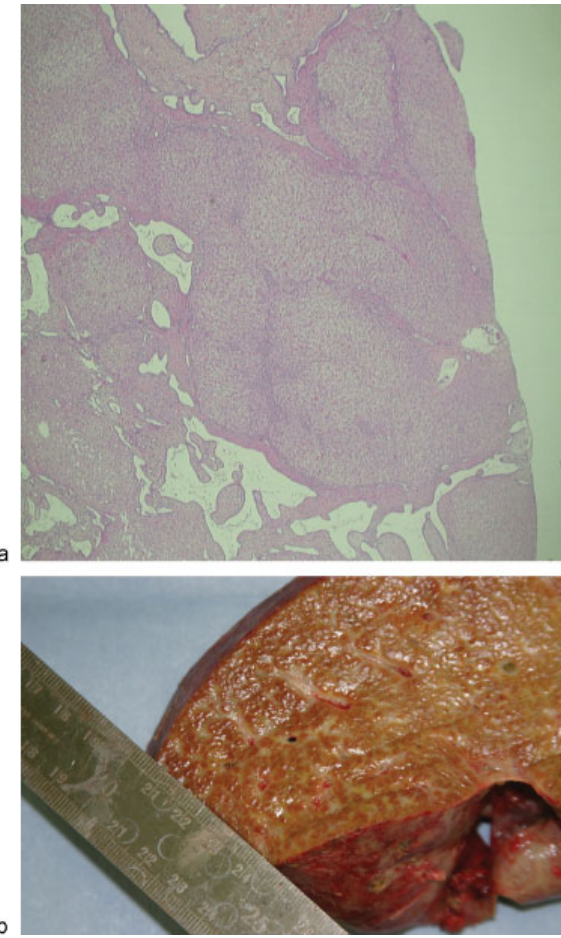
Fig. 2 ( a ) On histological examination of the liver biopsy specimen, portal areasgreatlyexpanded by fi broustissueand increased bile ducts are seen. The bands sometimes connect with adjacent portal tracts. Distorted irregular bile ducts are noted in the portal tracts (hematoxylin and eosin stain). ( b ) The recipient liver shows dark brown and